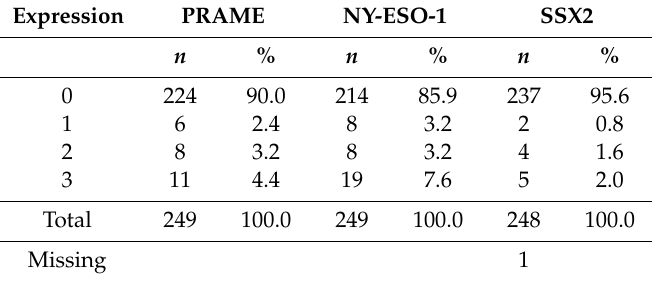
Table A1. Frequency of levels of expression for di ff erent Cancer Testis Antigens: 0, negative; 1, weak; 2, moderate and 3, strongly